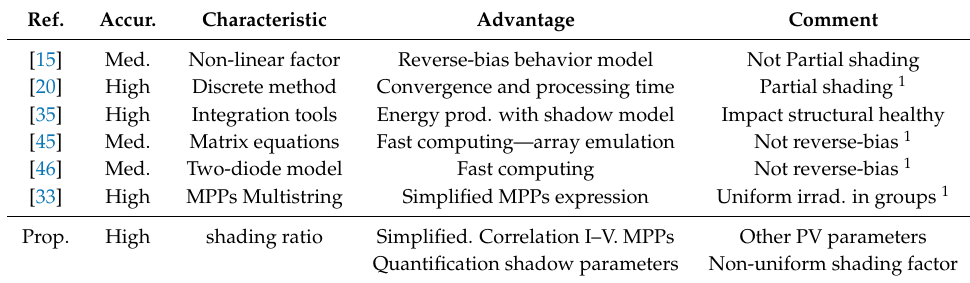
Table 12. Comparison with existing schemes in